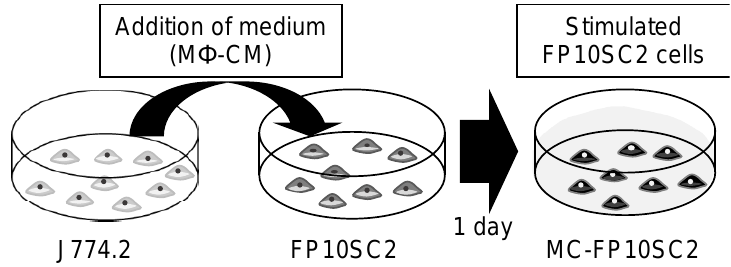
Figure 1. Schematic image of the in vitro stimulation model. Tumor-associated macrophage (TAM)-like macrophages (J774.2) were cultivated for 1 day, then the macrophage-conditioned culture medium (MΦ -CM) was collected and added to a culture dish on which cancer cells (FP10SC2) were growing. The cancer cells were cultured for 1 day to stimulate the cells with secretion molecules from the macrophages contained in the applied medium. After stimulation, the mechanical properties of the cancer cells were measured.